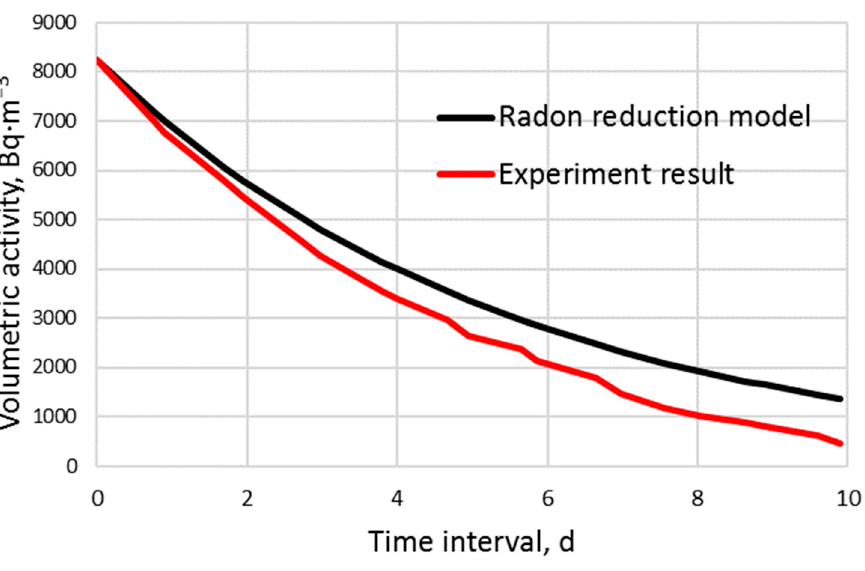
Figure 3. Radon leakage parameter assessment results.